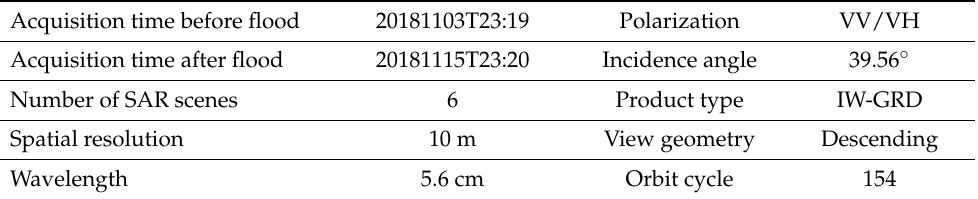
Table 2. Sentinel-2 optical images characteristics used for this